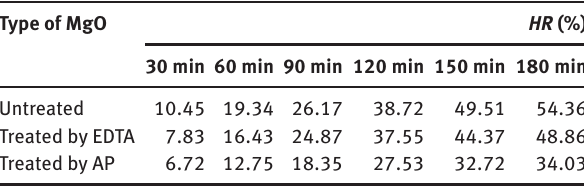
Table 2: Hydration degrees of different MgO with time at 25 ° C. Type of MgO HR